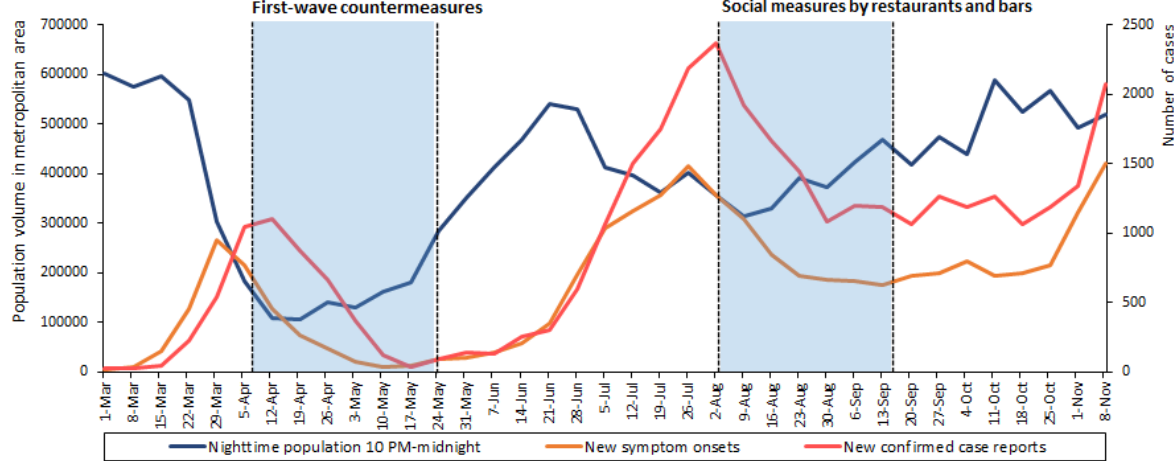
Figure 1. Nighttime population volumes in Tokyo metropolitan areas, number of new symptom onsets, and confirmed case reports of COVID-19 per week. LocationMind xPop © Location Mind